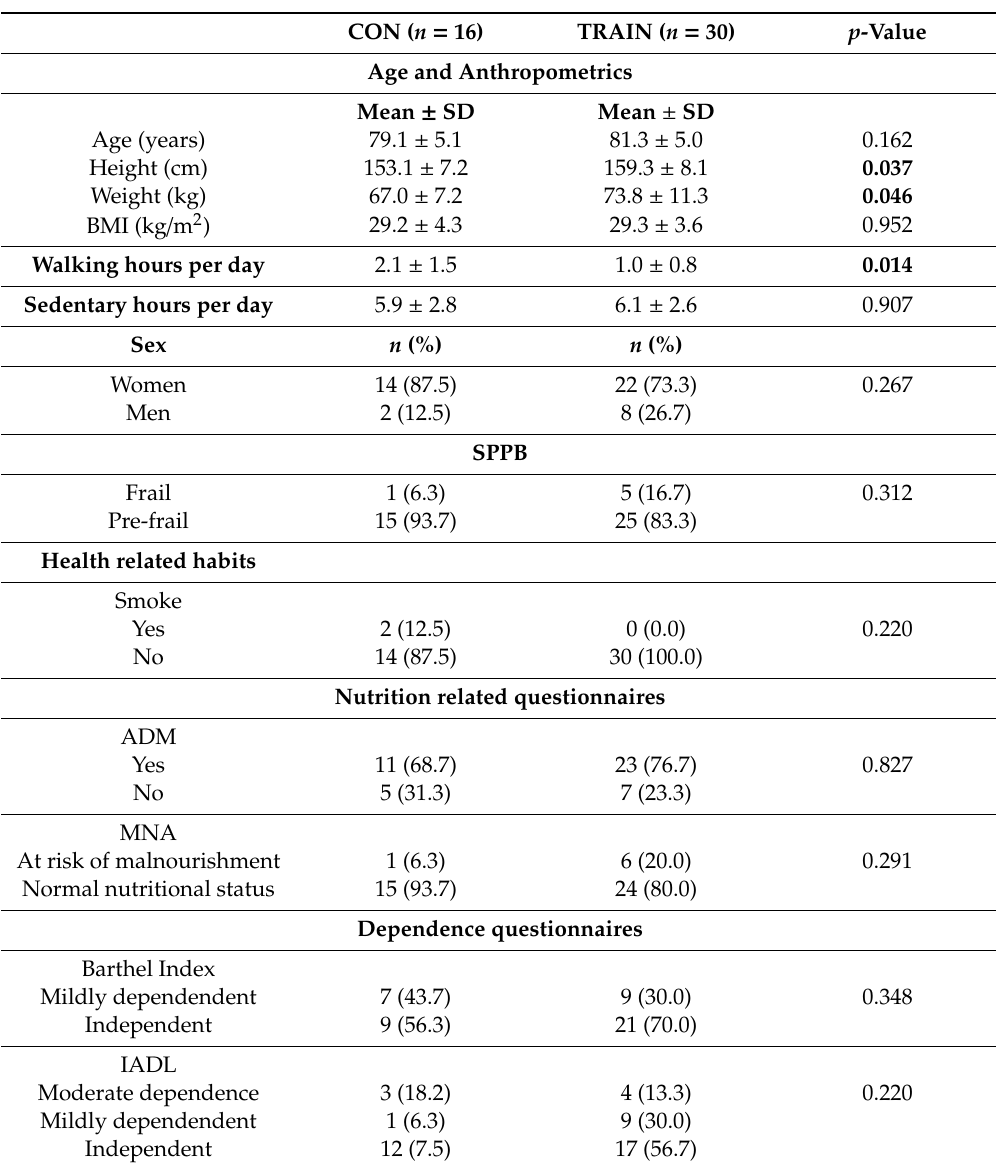
Table 1. Descriptive characteristics of the cohort at